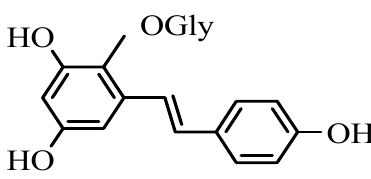
Figure 1. Chemical structure of